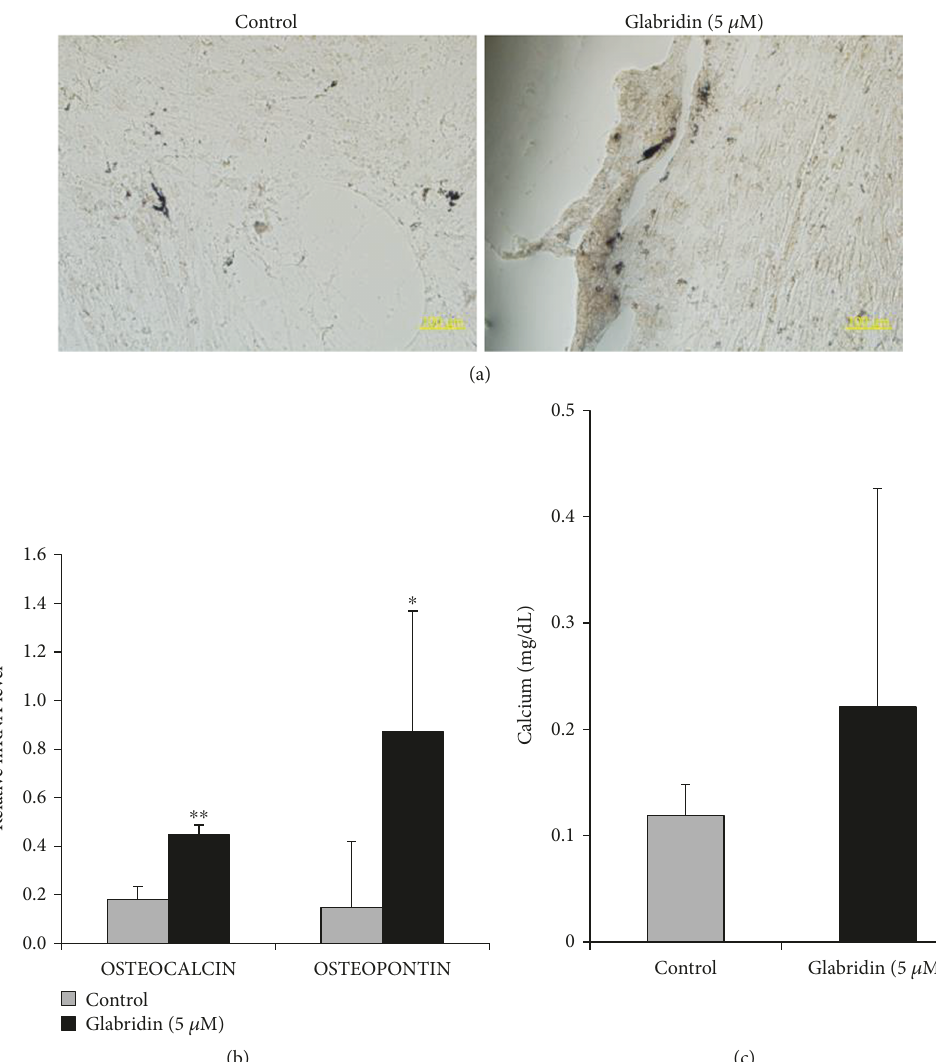
Figure 4: E ff ect of glabridin on osteogenesis in MSCs. (a) Osteogenic di ff erentiation was evaluated by von Kossa staining (magni fi cation: 200x). (b) Osteogenic potential was analyzed by OSTEOCALCIN and OSTEOPONTIN gene expression using RT-PCR. (c) Di ff erentiation of MSCs into osteoblasts was determined by calcium quanti fi cation. The data are expressed as the mean ± SD of three experiments. ∗ P < 0 05 and ∗∗ P < 0 01 versus untreated